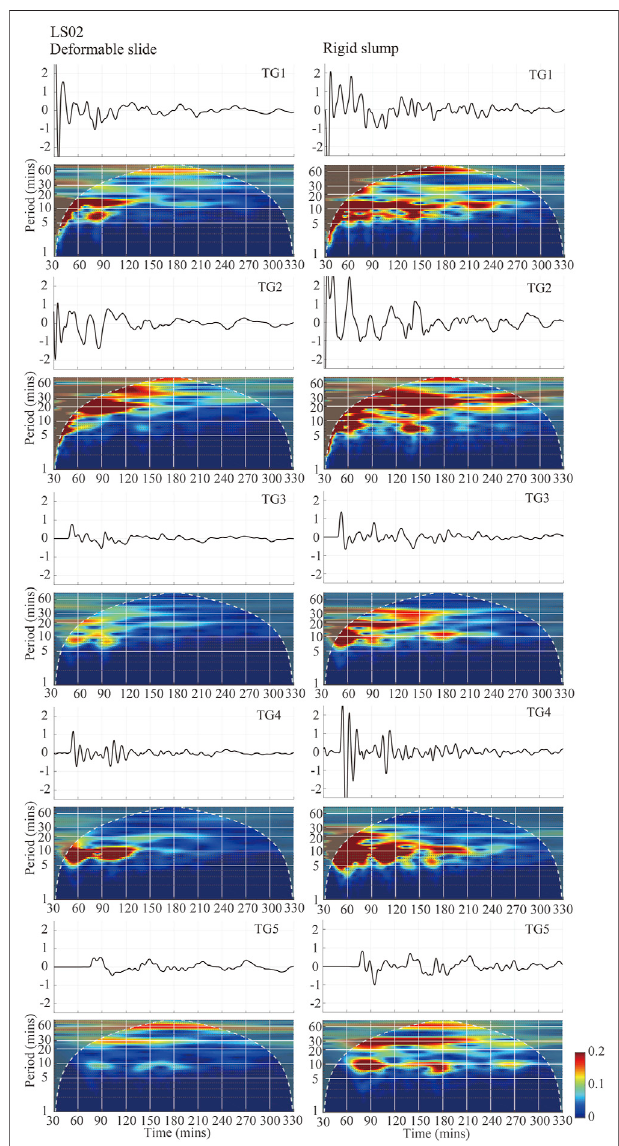
FIGURE 12 | Wavelet analysis of the tsunami waves generated by LS02 at TG1-TG5 for both deformable slide and rigid slump. Note: We use the CWT (continuouswavelettransforms)toanalyzetheperiodsoftsunamiwaves.Thecone of in fl uence indicates where edge effects occur in the CWT. Gray regions outside the dashed white line delineate regions where edge effects are signi fi cant.